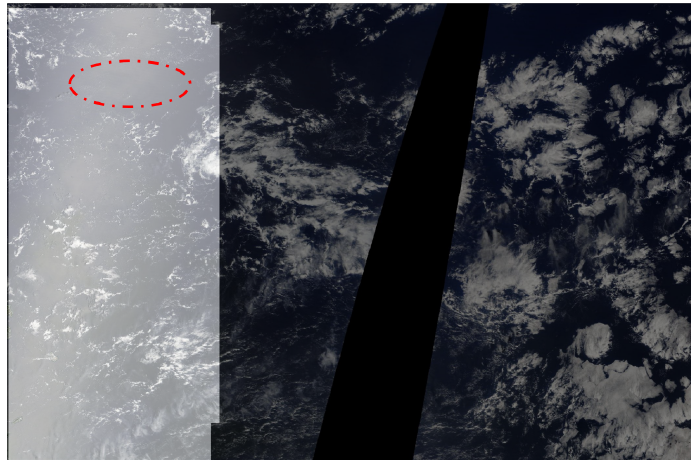
Figure 12. Label error